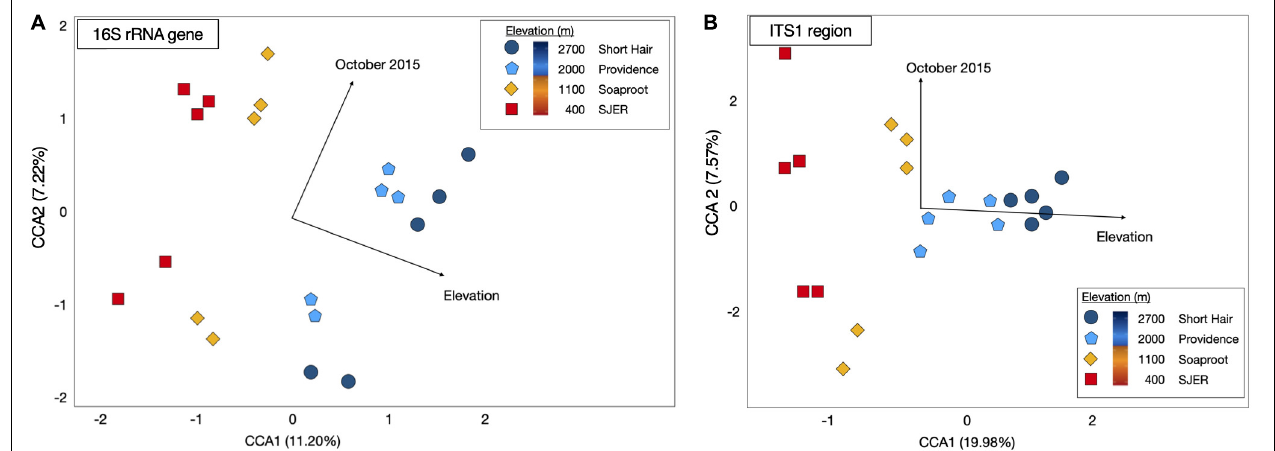
FIGURE 4 | Canonical Correspondence Analysis (CCA) for dust-bacterial 16S rRNA targeted amplicons from marker genes (A) and ITS1 region amplicons for dust-fungal (B) microbiomes. Elevation and October sampling date contributed to structuring microbial communities. Dust-associated bacterial (16S rRNA marker gene amplicons) communities from 2015 were colored by site [colored symbols, (A) ]. Dust fungal communities (ITS1) from 2015 were shown in (B) . Both fungal and bacterial communities were structured by elevation and the October 2015 sampling date, as evidenced by arrows representing the direction of the effect; arrow length corresponded to the magnitude of the effect of these environmental or temporal variables. CCA1 for dust-associated bacteria represented 11.20% of the variation; CCA2 for these bacterial 16S rRNA OTUs represented 7.22% of the variation; CCA1 for dust-associated fungal ITS communities represented 19.98% of the variation; CCA2 for dust fungal amplicons represented 7.57% of the variation in the composition of these